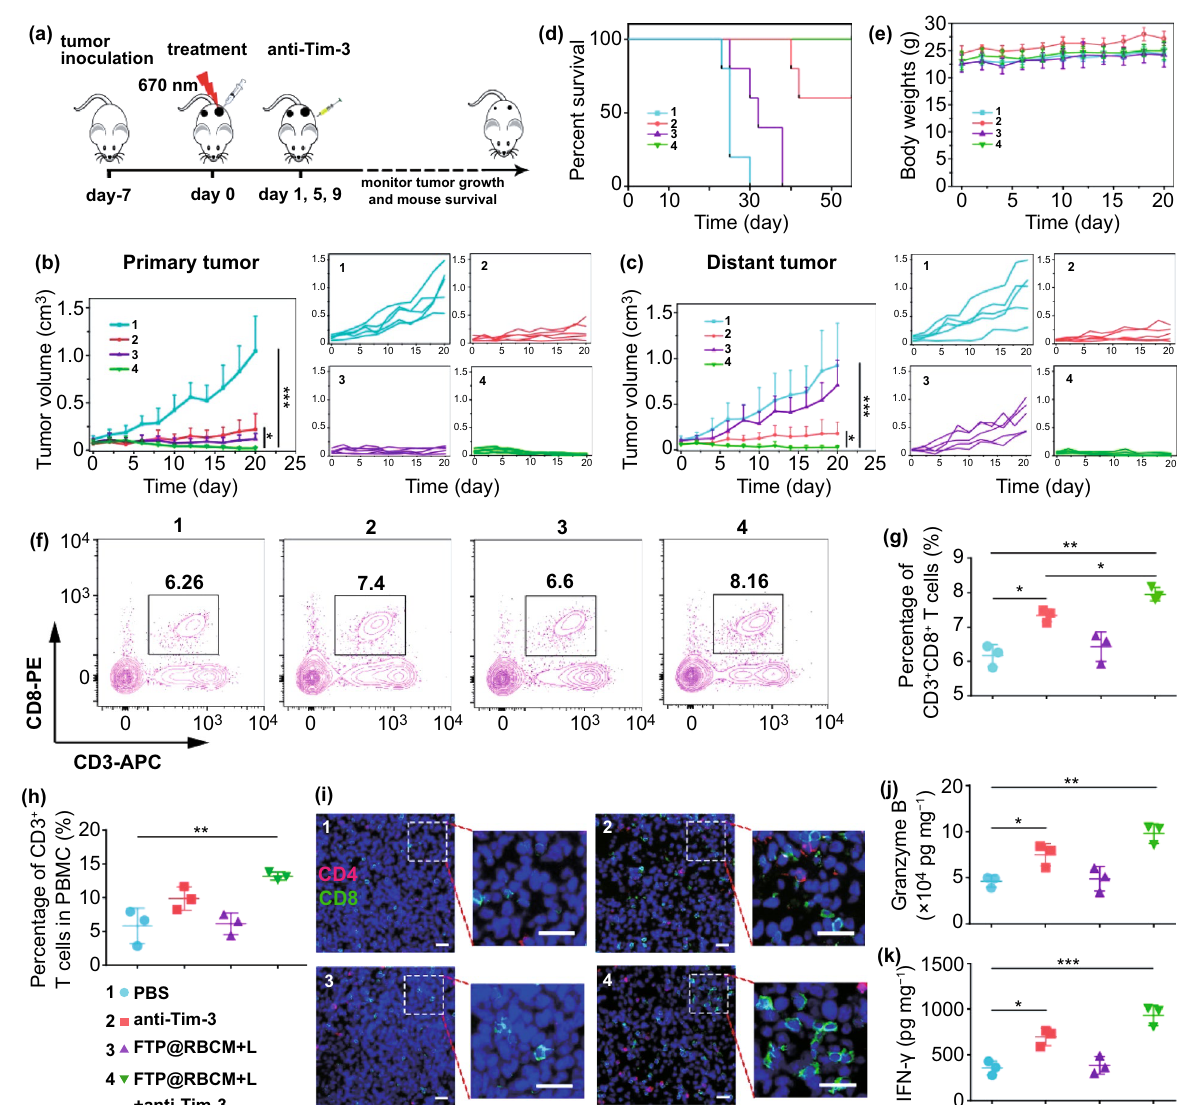
Fig. 6 a Schematic illustration of combined therapeutic procedures of FTP@RBCM-mediated radical therapy combined with Tim-3 checkpoint blockade. b, c Relative growth and average relative growth curves of primary tumors ( b ) and abscopal tumors ( c ) ( n = 5). d Survival curves of mice ( n = 5). e Average body weights of mice ( n = 5). f Representative flow cytometry plots of CD3 + CD8 + T cells in spleen. g Statistical analysis of CD3 + CD8 + T cell frequency according to the data in f . h Statistical analysis of CD3 + T cell frequency in PBMC. i Immunofluores- cence staining images of the infiltrated CD4 + T cells (red) and CD8 + T cells (green) in abscopal tumor slices. Scale bar = 50 µm. j, k Cytokine levels of Granzyme B ( j ) and IFN-γ ( k ) in abscopal tumor tissues. 1: PBS group; 2: anti-Tim-3 group; 3: FTP@RBCM + L group; 4: FTP@ RBCM + L + anti-Tim-3